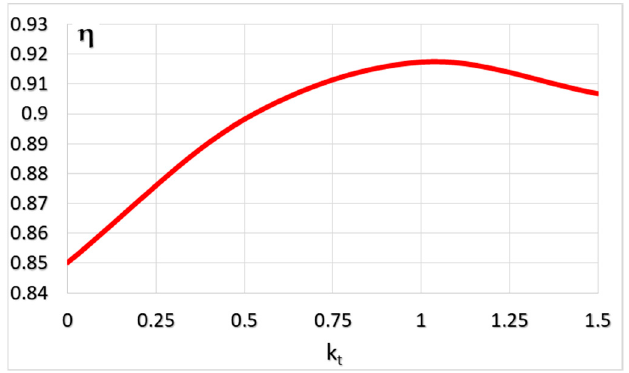
k (Case A). Figure 6. Variations of the planetary transmission efficiency, depending on k t (Case t